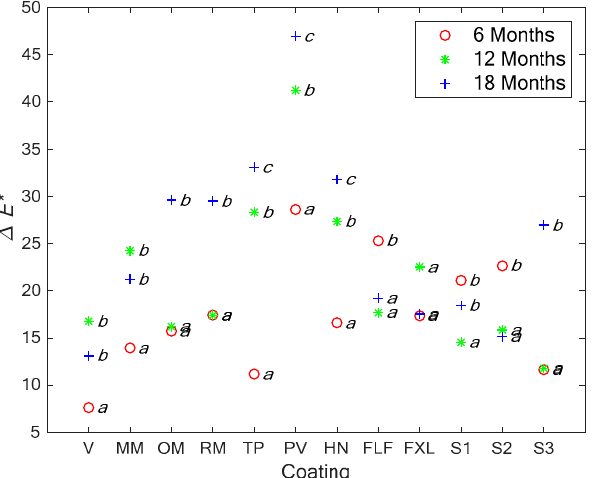
Figure 11. Games–Howell pairwise mean differences of color change for red alder wood for each coating during the study. Superscripts indicate means between intervals that are not significantly different at the p < 0.05 level.